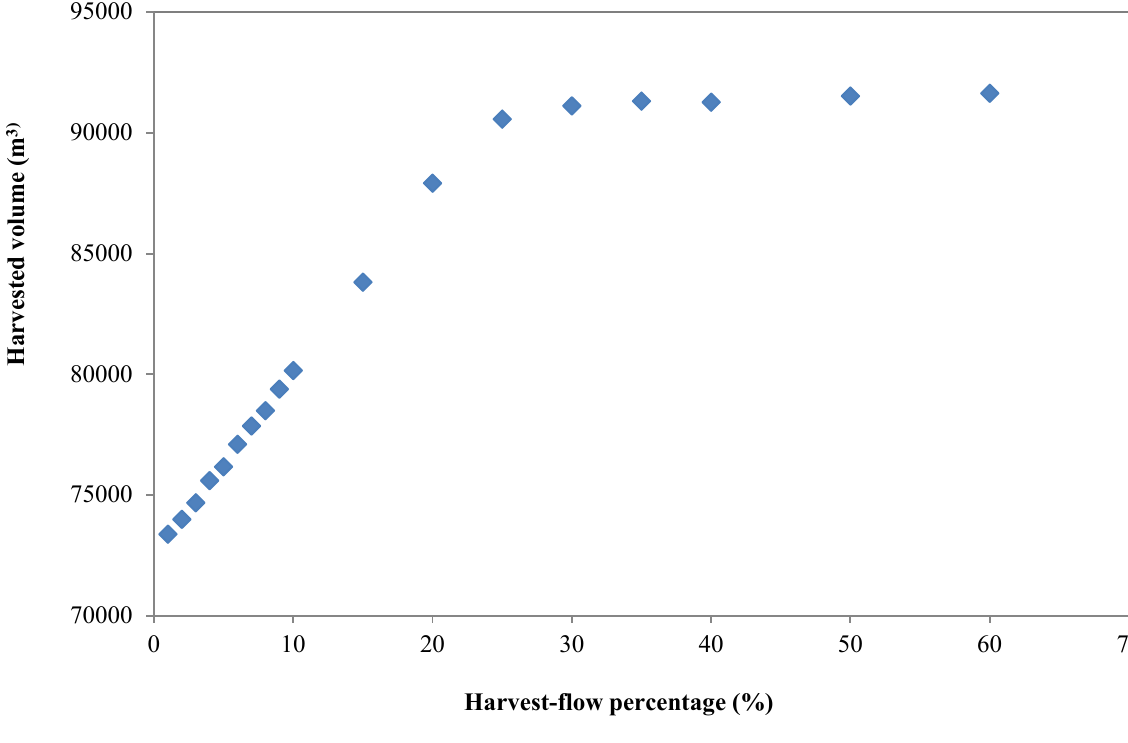
Figure 8. The relations between harvest flow percentage and total harvested volume for ComP-M variant and 1.00 × 10 −4 gap